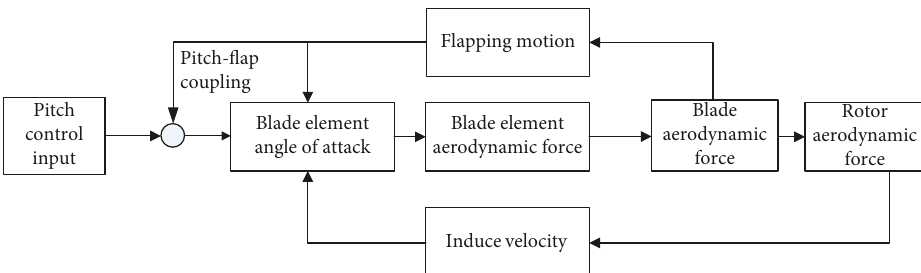
Figure 2: Rotor aerodynamic calculation diagram.